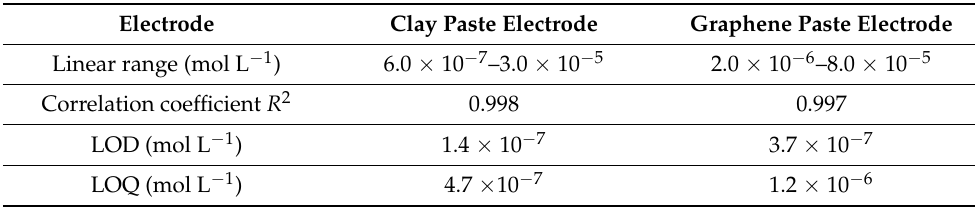
Table 1. Regression parameters for determination of PA on ClPE and GrPE, n = 3.